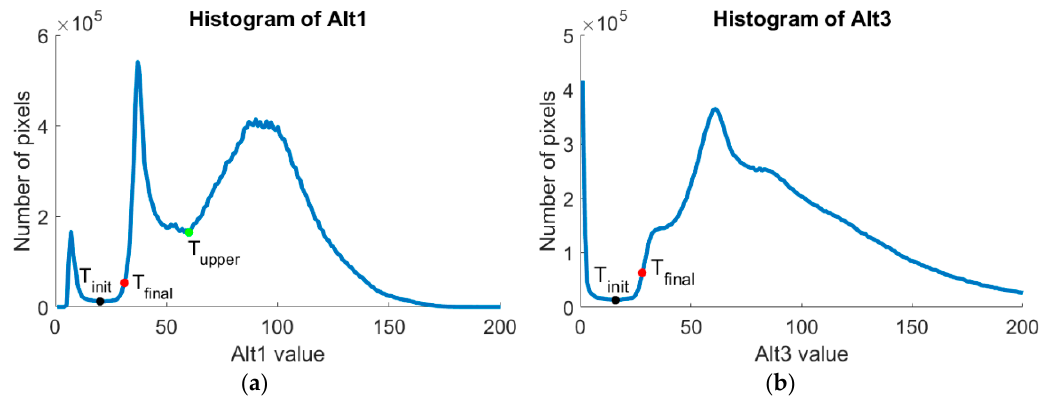
Figure 13. Histogram of the ( a ) Alt1 and ( b ) Alt3 maps for Doñana on 20 August, 2017. T init is the value for which the first deep valley in the Alt1 and Alt3 histograms is detected (black point). The red point on Alt1 and Alt3 histograms corresponds to T final estimated relying on MCET. The deep valley right after the first valley in the Alt1 histogram corresponds to threshold T upper . T upper cannot be detected on the Alt3 histogram. (Histograms’ values reach up to 255. However, since there are a few pixels with value over 200 that do not cause fluctuations of the histograms’ curves, the upper limit of the x-axis is set to 200 for visualization reasons.).